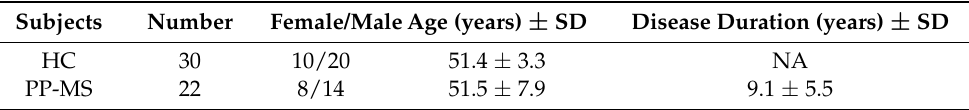
Table 1. Patient